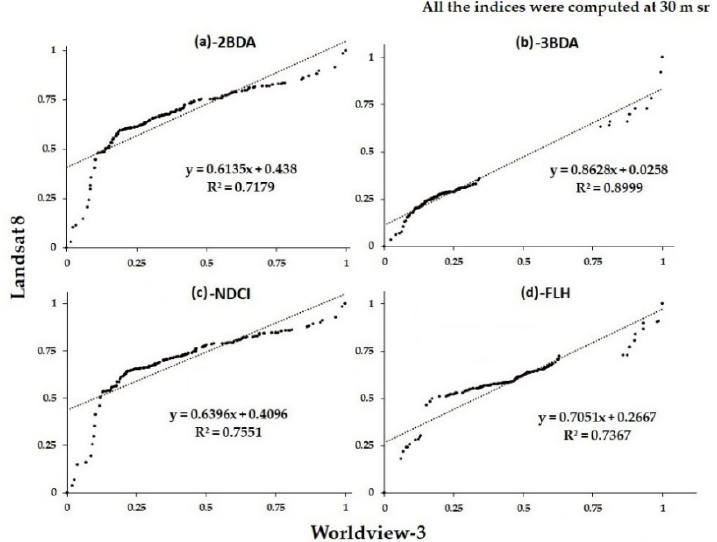
Figure 6. Correlation between Landsat 8 Chl a concentration and Worldview at 30-m spatial resolution (sr).